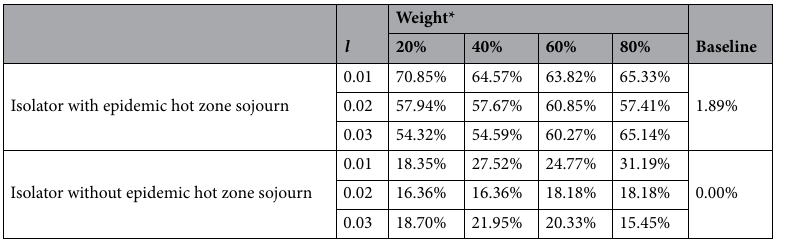
Table 1. Recall of COVID-19 exposure risk in test set. *in order to study the influence of the loss function’s weight on the exposure risk prediction better, the weights of rare categories are not set as a constant value, but set as the proportion of training set sample